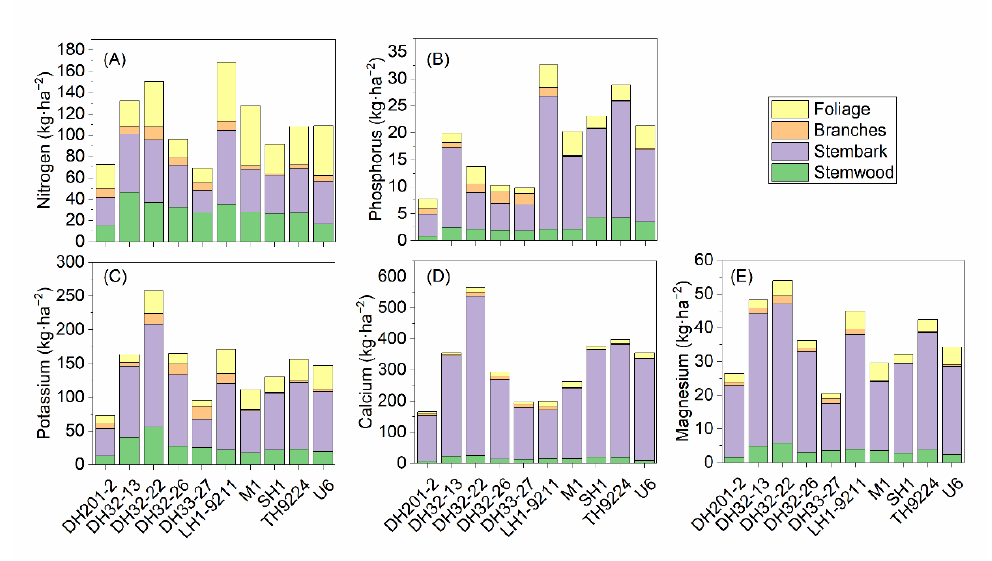
Figure 5. Nutrients content of various tree components for ten Eucalyptus Clones. ( A ) Nitrogen con- tents, ( B ) phosphorus contents, ( C ) potassium contents, ( D ) calcium contents, ( E ) magnesium con- tents.